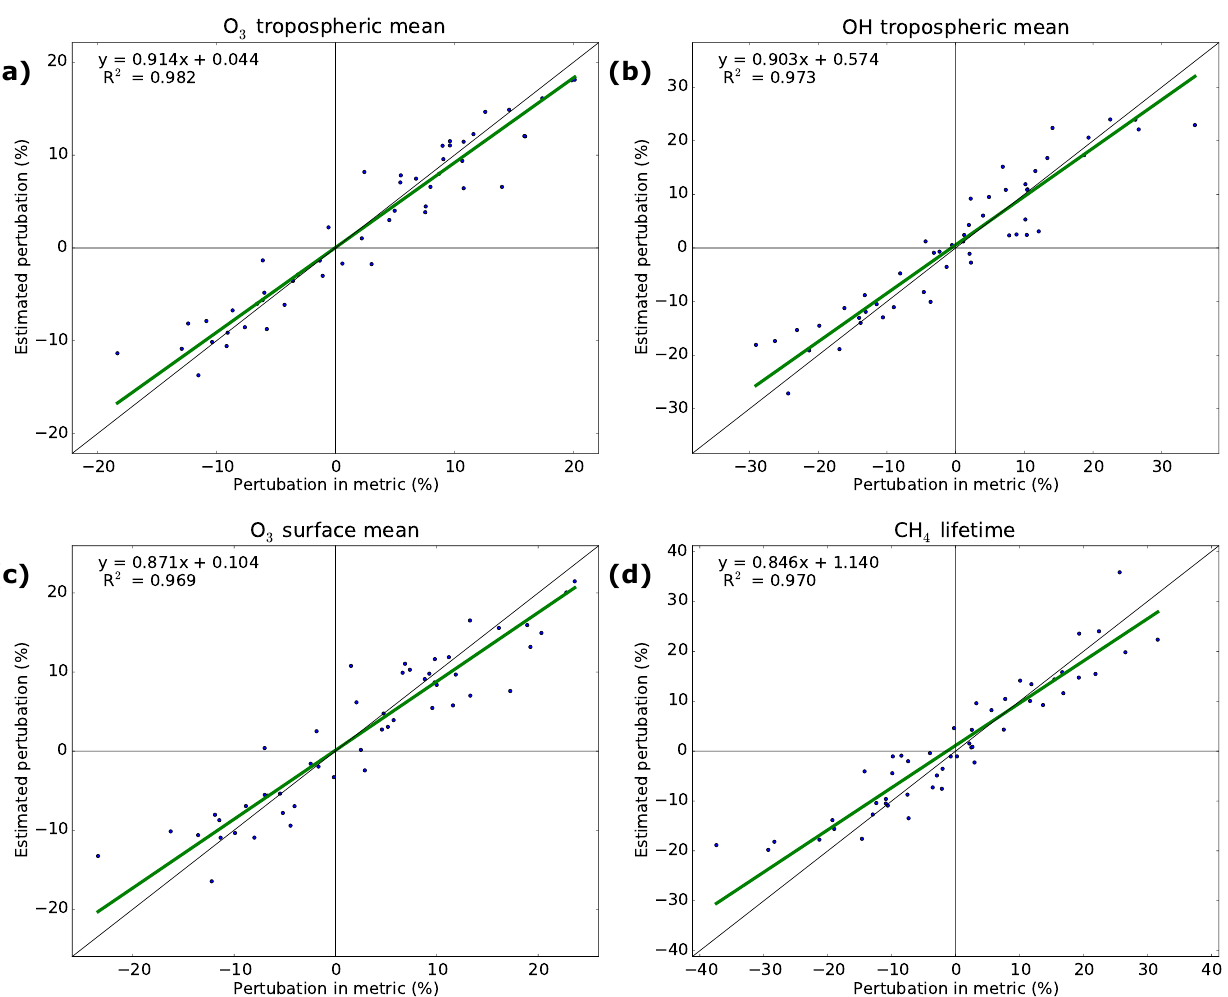
Figure 4. Monte Carlo simulations to understand the models’ linearity: the x -axis values show the percentage change in the metric value of an ensemble member compared to the simulation with no perturbations. The y -axis values show the expected percentage change of the metric based on a linear addition of the individual 1 σ perturbation experiments weighted by the Monte Carlo perturbation values. Metrics investigated are (a) O 3 tropospheric burden, (b) OH tropospheric burden, (c) O 3 mean surface concentration and (d) CH 4 lifetime. We show the result of 50 Monte Carlo simulations. Each simulation perturbs 10 of the most important reactions ( ∗ reactions in Table 1) 1 σ by normally distributed random